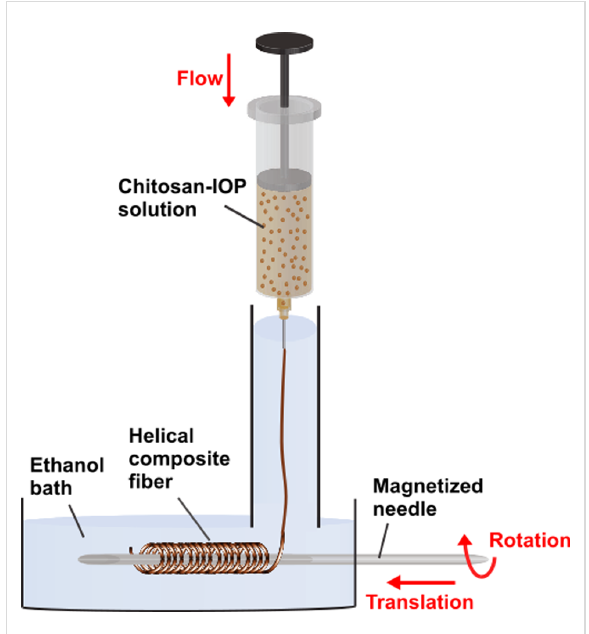
Figure 6: Scheme of the wet-spinning process that generated helical microfibers. A solution of chitosan and magnetic iron oxide nanoparti- cles was extruded into an ethanol coagulation bath. The emerging fibers were collected by a teflon-coated rotating needle with a stain- less steel core, which simultaneously performed a translational move- ment to achieve a helical fiber